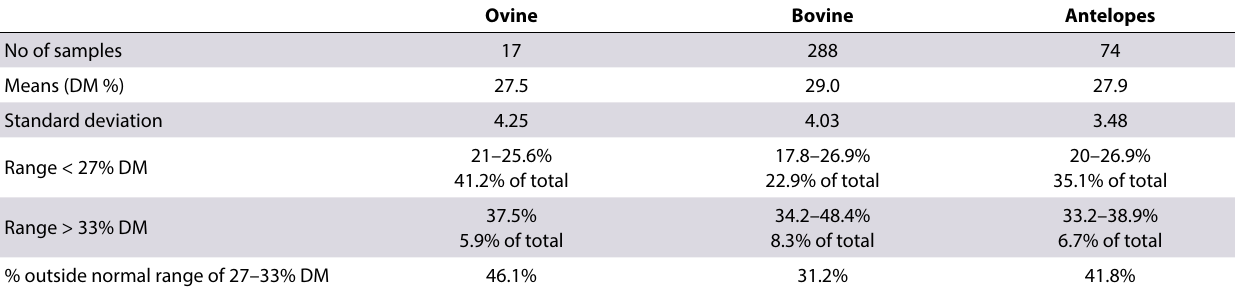
Table III: Dry matter (DM) content of liver samples from ovine, bovine and antelope species, analysed at the UP Nutrilab